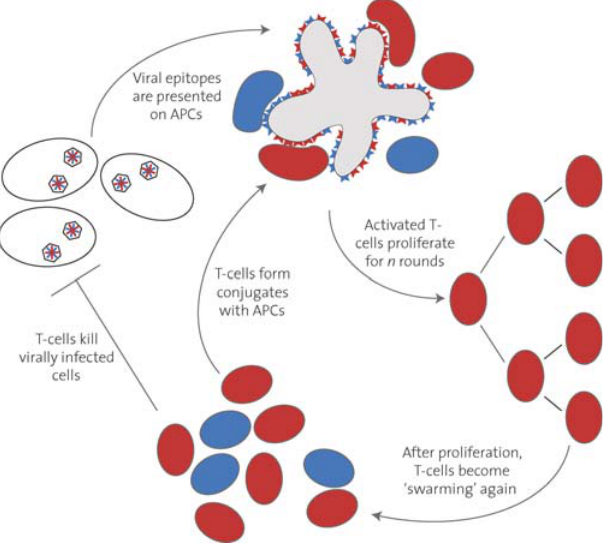
Figure 1. The Basic Features of the IBM The production of APCs depends on the number of virally infected cells. APCs express two to n different pathogen epitopes. We refer to the infecting pathogen as a virus in this paper, but the model applies to all intracellular pathogens and extracellular pathogens that enter the MHC class I presentation pathway via cross-presentation [78,79]. For simplicity, APCs present the same amount of each epitope, though in